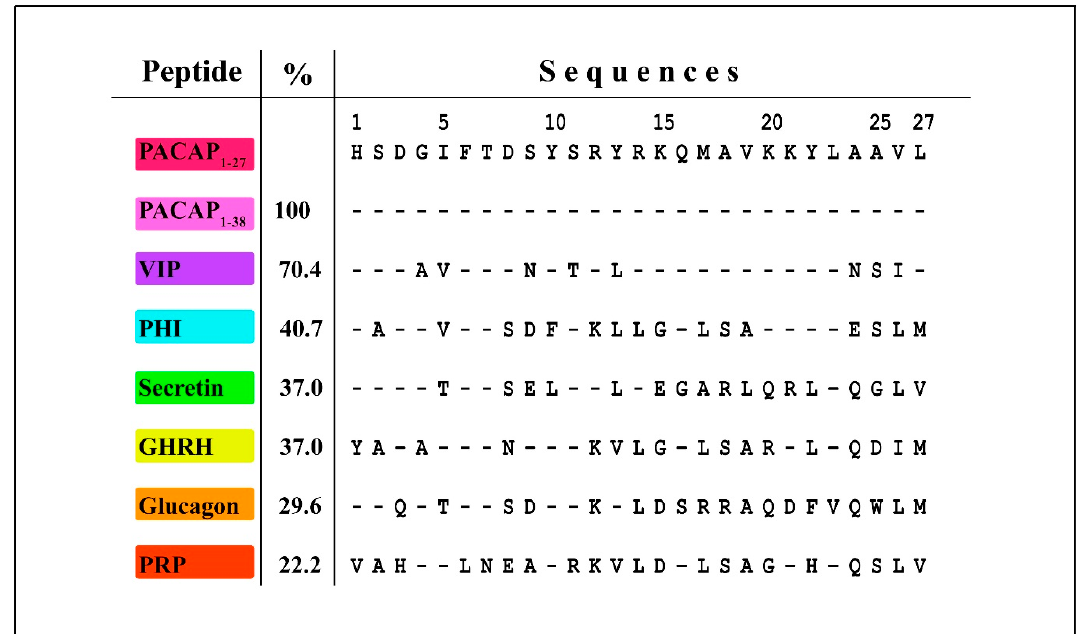
Figure 1. Core PACAP1-27 sequence homology within the human PACAP / glucagon family (PACAP paralogs). Peptide names and abbreviations are indicated at left. Amino acids are given in the single letter code, the numbers on the top show their positions. Sequence comparison was performed by BLASTP v.2.9.0 search on Non-redundant GenBank CDS translations + PDB + SwissProt + PIR + PRF databases. The numbers at right indicate percent homologies. Accession numbers: